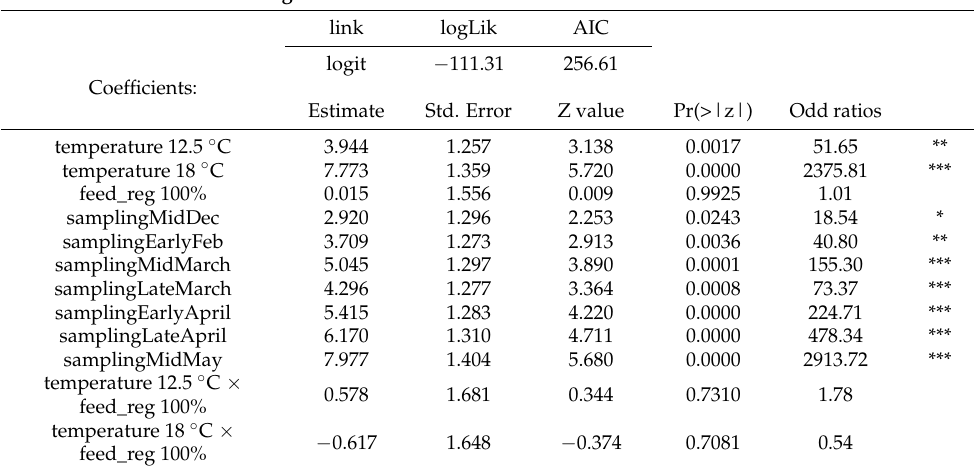
Table 3. Model coefficients, estimates, p -values, odd ratios, and significance of model terms of the ordinal logistic regression with the formula presented below. Asterisks in the last row indicate the significance of the model terms, and are displayed as follows: (*) p -value < 0.05, (**) p -value < 0.01, and (***) p -value <